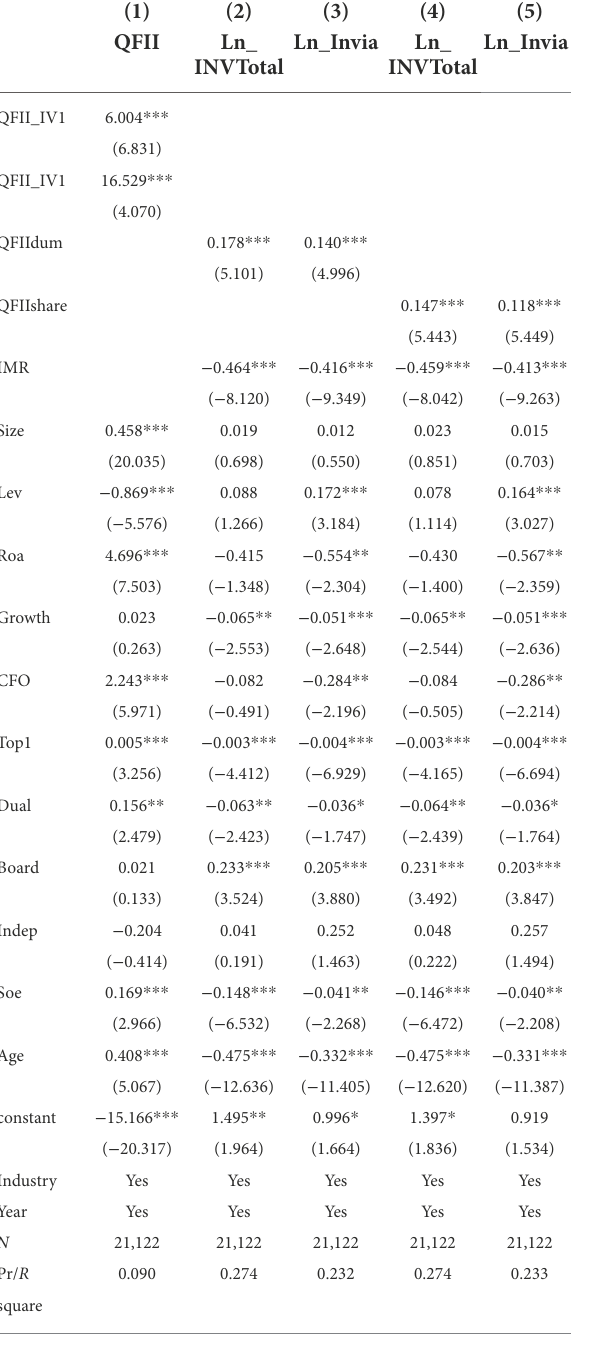
TABLE 8 Robustness test: The impact of QFII on the quantity and quality of corporate innovation—based on Heckman’s test.